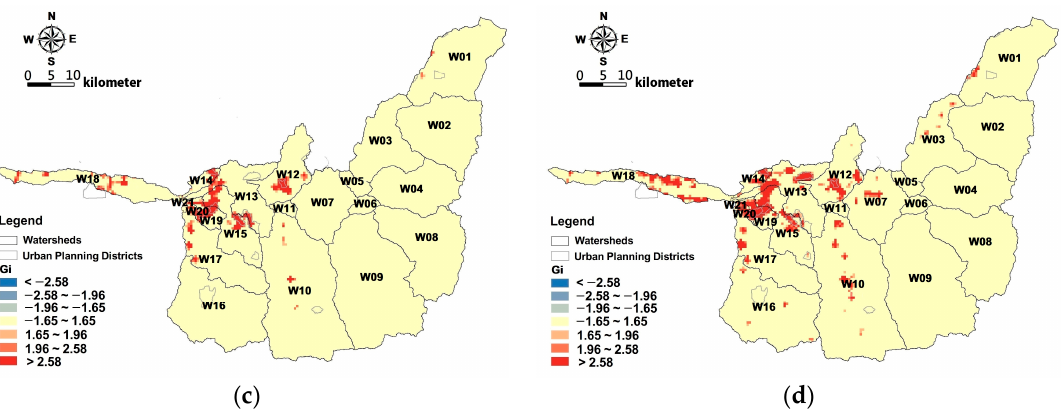
Figure 2. Hotspots of artificial structures on basin scalein ( a ) 1998; ( b ) 2003; ( c ) 2008; ( d ) 2013.